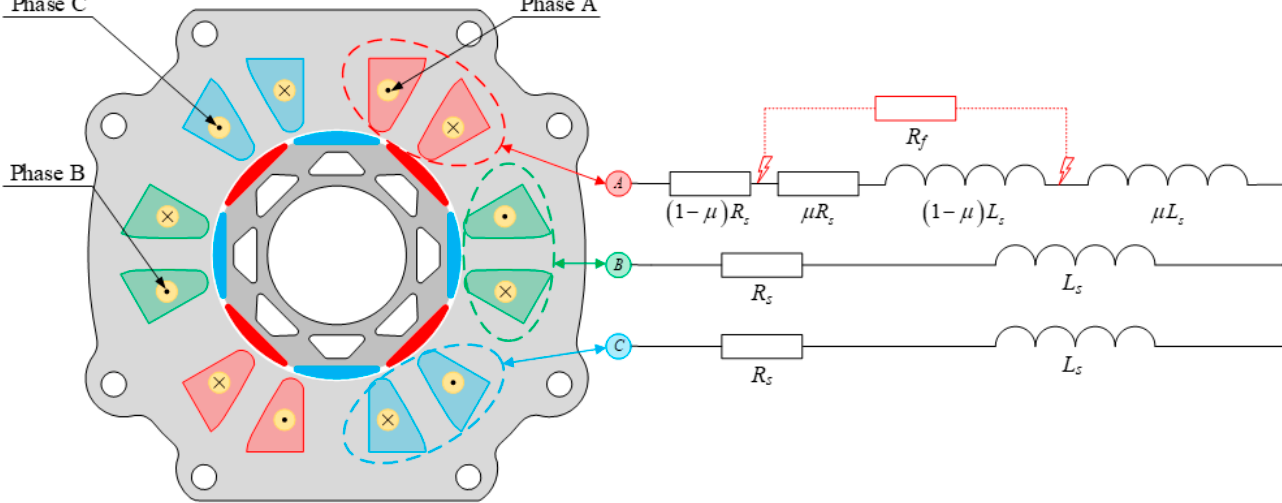
Figure 1. Equivalent circuit of the PMSM stator winding with shorted turns in phase A .